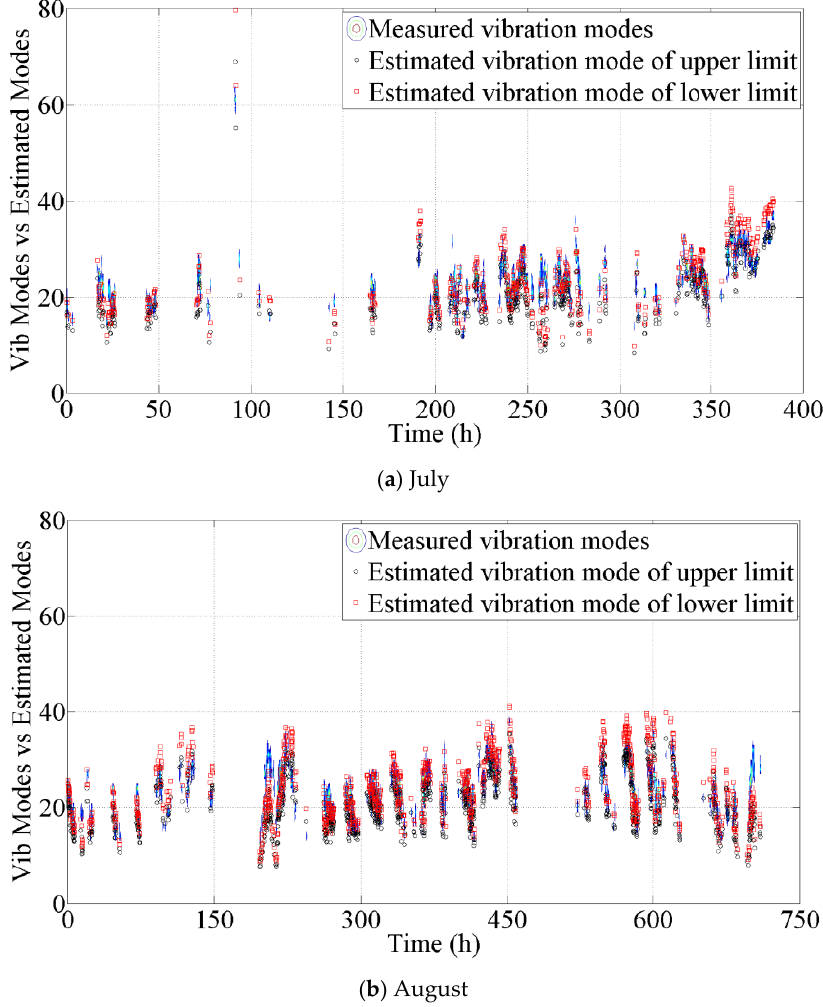
Figure 19. Comparison of measured vibration modes and estimated vibration modes. ( a ) Measured vibration modes versus estimated results in July; ( b ) Measured vibration modes versus estimated results in